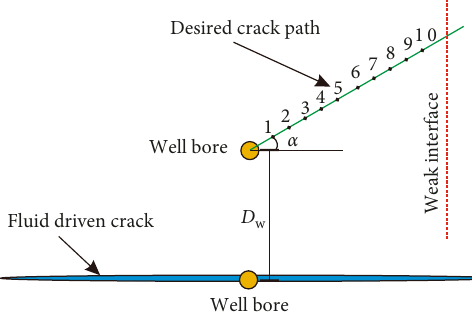
Figure 13: Schematic of target path and target points for crack orientation